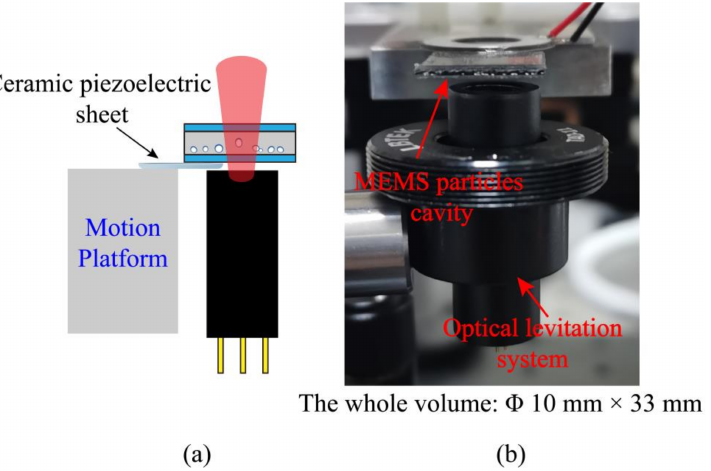
Figure 5. Miniature optical levitation system. ( a ) Overall schematic diagram; ( b ) Photograph of the miniature optical levitation system.